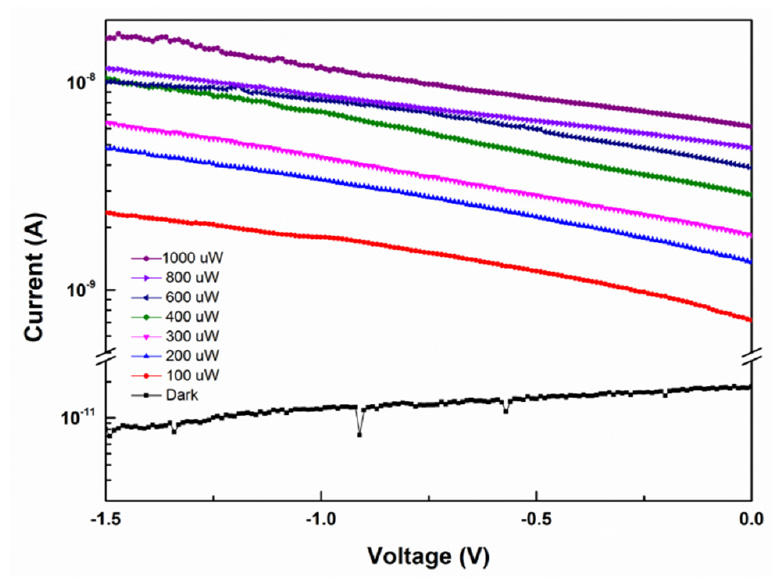
Figure 9. I–V curve of Ag:AZO 20 nm device at different UV light intensities. Figure 10 shows the photocurrent densities of the photodetectors to which each electrode was applied over time, when irradiated with UV radiation with an intensity and wavelength of 1000 µ W/cm 2 and 254 nm, respectively, in zero bias. Ag:AZO exhibited the highest photocurrent density of 31 µ A/cm 2 , compared with AZO and Ag, which had photocurrent densities of 27 µ A/cm 2 and 18.6 µ A/cm 2 . There are two reasons for this phenomenon. First, because of the low surface roughness, loss due to scattering and the reflection of light energy incident on the surface of the thin film is relatively small. Second, because of the low roughness of the electrode, sufficient bonding between the interface layers is achieved, resulting in lower contact resistance. Therefore, it is expected that the largest photocurrent appears in the photodetector using the 20 nm Ag:AZO electrode with the lowest roughness.